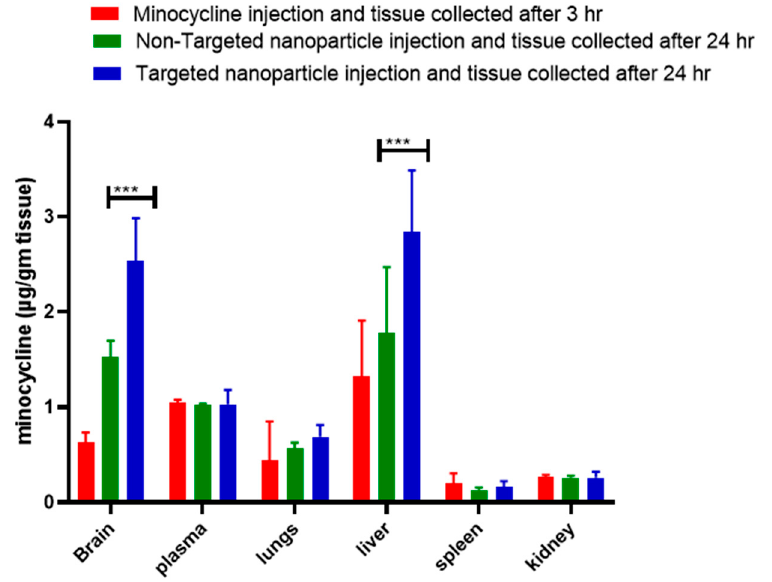
Figure 7. Biodistribution of minocycline and targeted nanoparticle in a rat model moderate blast TBI. Two-way Anova, Multiple comparison analysis *** p < 0.001.